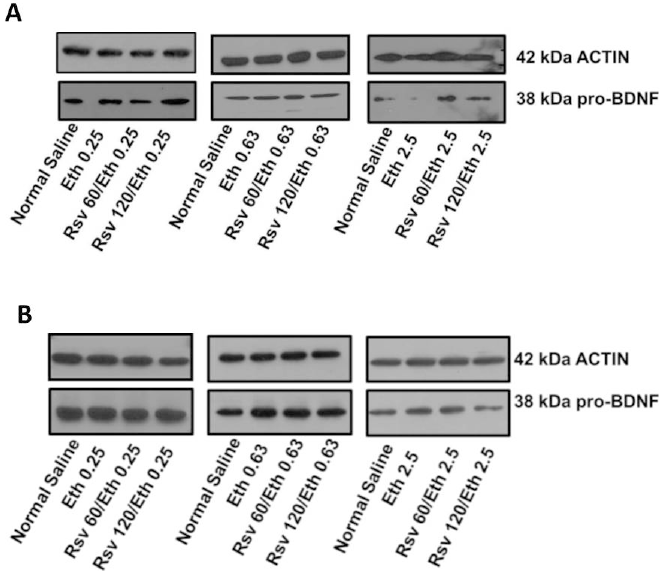
Figure 3. Eth alone or in combination with Rsv affects the pro-BDNF protein level in pregnant rats but not in the embryos. ( A ) Higher doses of Eth decreased pro-BDNF protein levels in the hippocampus of pregnant rats. Rsv in combination with the lower doses of Eth increased pro-BDNF protein levels in these tissues; ( B ) In the tissue extracts from embryos, Eth alone or in combination with Rsv had no effect on the pro-BDNF protein level. Immunoblots were arranged to identify pre-mature (pro-) BDNF in tissue extracts from hippocampi of pregnant and embryonic rats. β -actin was used as a loading control. Each blot is representative of three replicates. Antibodies against BDNF and β -actin detected proteins bands of approximately 38 and 42 kDa for pro-BDNF and β -actin, respectively.